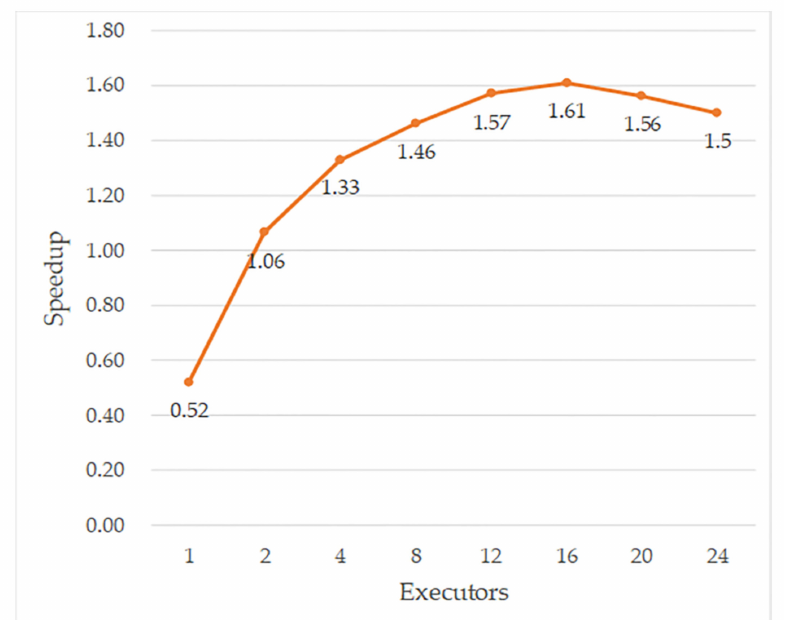
Figure 14. The relationship between the number of executor-allocated single-core processing units and the speedup in the case of three nodes: the x -axis represents the number of executors. The y -axis represents the speedup as the number of executors